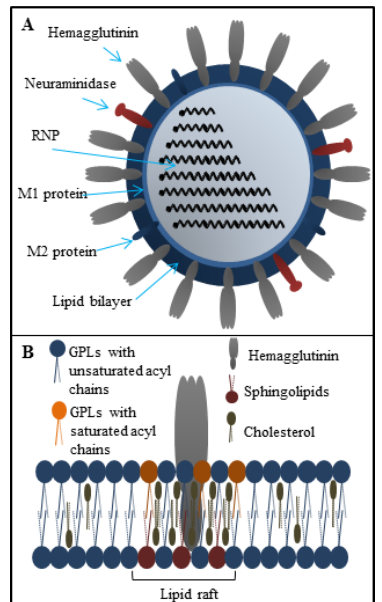
Figure 1. ( A ) The structure of influenza virus particle; ( B ) Structure of the lipid raft localized in the influenza lipid bilayer. The lipid rafts are composed mainly from glycolipids (GPLs), cholesterol and sphingolipids. These microdomains are responsible for the effective viral fusion.